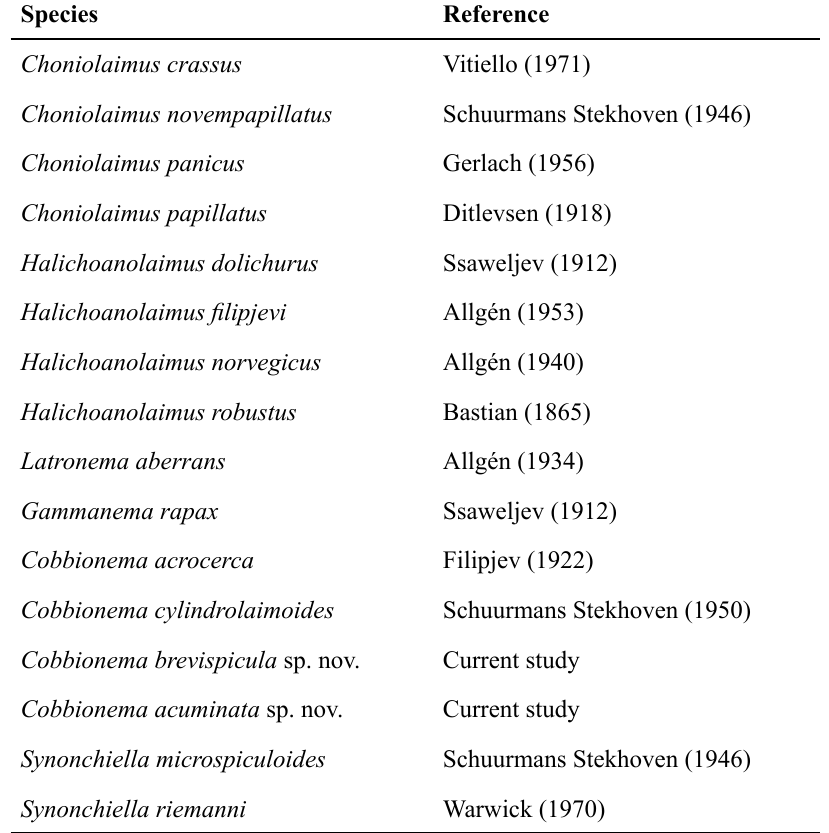
Table 4. Species of the family Selachinematidae recorded from marine habitats in